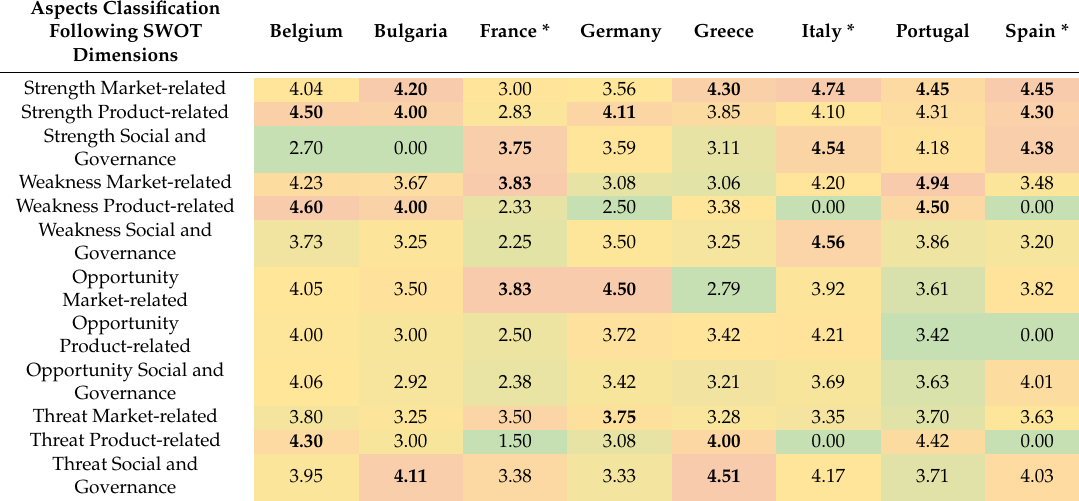
Table A3. Aspects Relevance Heatmap by Country.